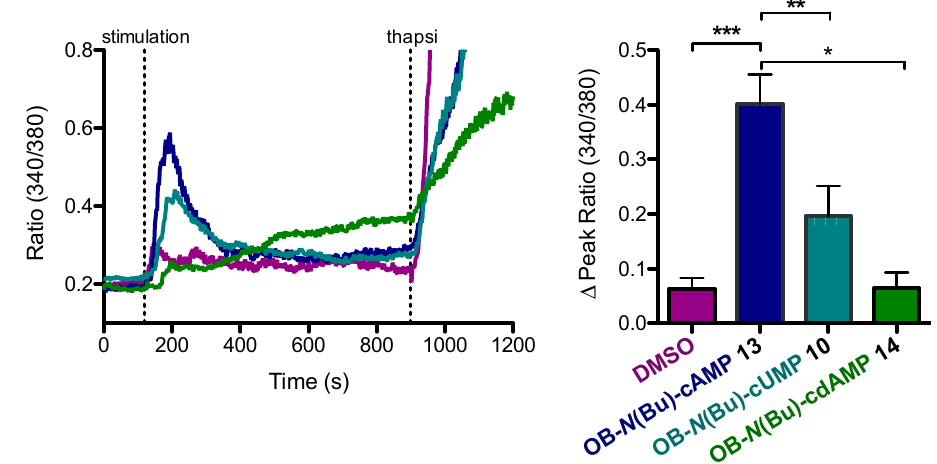
Figure 8. Stimulation of the of Jurkat T cells with OB-cNMPs 10 , 12 , and 13 . Left: Jurkat T cells were stimulated after 120 s with the respective OB-cNMPs (20 µ M) or DMSO (as negative control). Furthermore, as positive control Thapsigagarin (1.67 µ M) was added after 900 s. Mean signal ratio between 340 nm and 380 nm from single cells are shown (DMSO n = 26; OB cAMP n = 77; OB cUMP n = 37; OB c(dAMP) n = 14). The addition of 12 and 10 resulted in a transient increase of the Ca 2+ concentration, while no transient increase is visible for 13 or DMSO. Right: Statistical analysis of the mean delta peak for the OB-cNMPs and DMSO (data represent mean ± SEM). The most pronounced effect is measured for 12 and statistically significant differences between are marked by asterisks (* p < 0.05, ** p < 0.01, *** p < 0.001, Kruskal–Wallis Test).